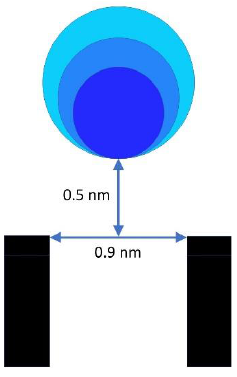
Figure 13. PNP calculations indicate that a sphere composed of 10 elemental positive charges whose lower edge is located 0.5 nm from the opening of a 0.9 nm diameter pore (5 nm in length) will produce a rectification of approximately 100 nS/100 mV in an aqueous medium containing 1 M monovalent salt. The spheres are 0.3, 0.4, and 0.5 nm in radius, each of which could produce the observed rectification. To save space, only a portion of the pore is